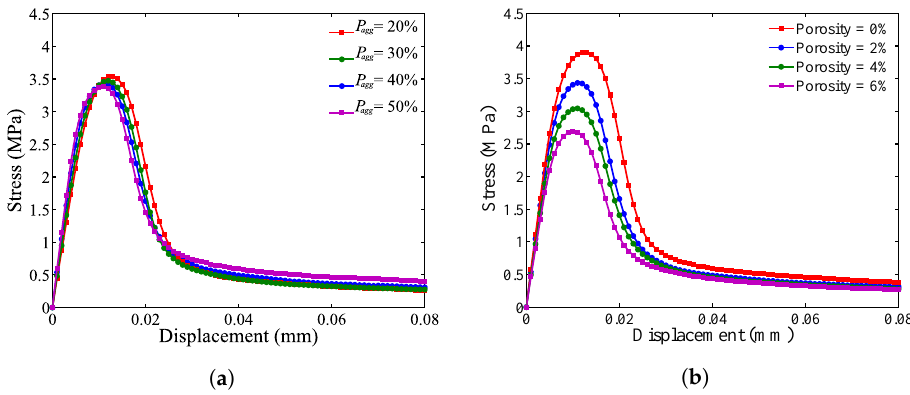
Figure 13. Effect of ( a ) aggregate volume fraction, P agg , and ( b ) porosity, P pore , on the mean stress